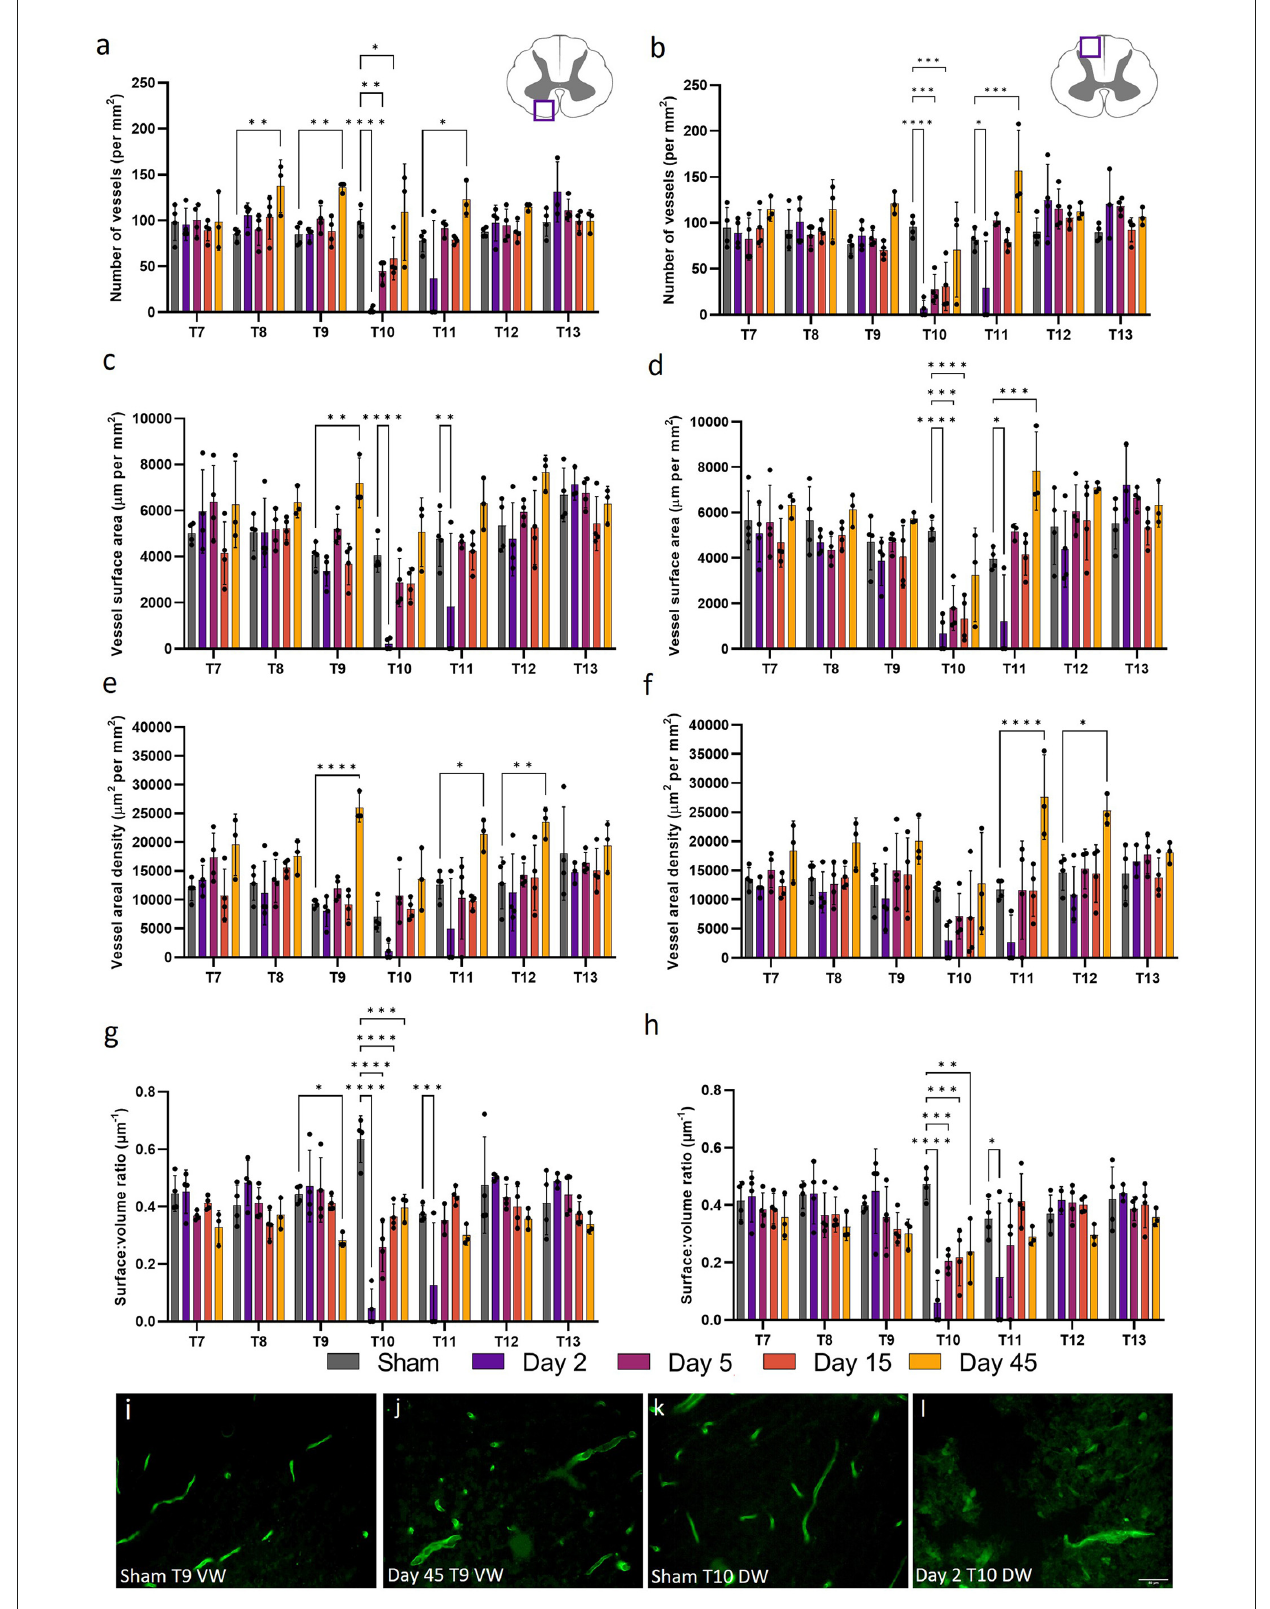
FIGURE5 Microvessel morphology was significantly altered 45 days after spinal cord injury in the white matter. Vessel density (A,B) , surface area (C,D) , and areal density (E,F) were used to assess microvascular changes following spinal cord injury in the ventral (A,C,E) and dorsal (B,D,F) white matter.